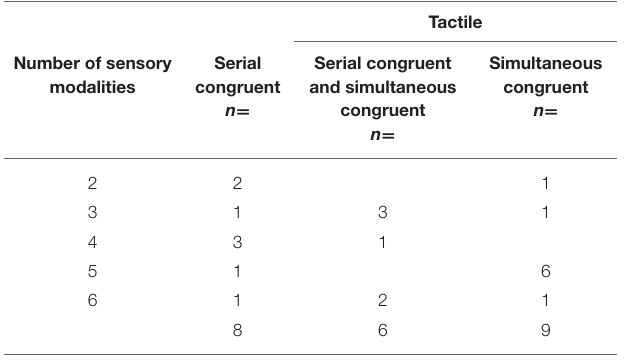
TABLE 4 | Phenomenological characteristics of the tactile and somatic hallucinations Tactile